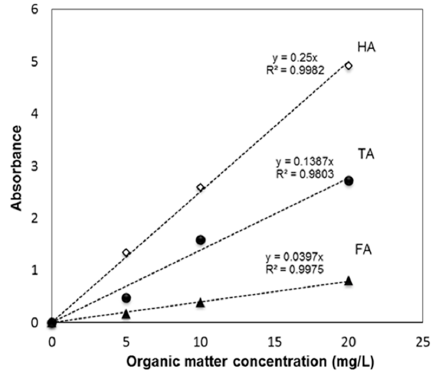
Figure 1. Absorbance versus concentration of humic acid (HA), tannic acid (TA) and fulvic acid (FA) (NaCl 10 − 2 M; pH